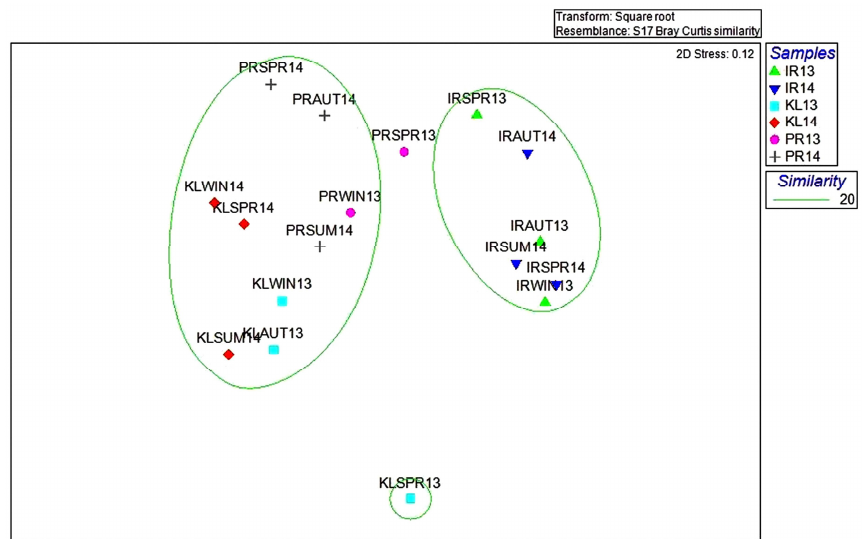
Figure 7. Nonmetric multidimensional analysis (MDS). Ierissos: IR; Kalymnos: KL; Preveza: PR; Spring: SPR; Summer: SUM; Autumn: AUT; Winter: WIN; 13 and 14 indicate the years 2013 and 2014, respectively.